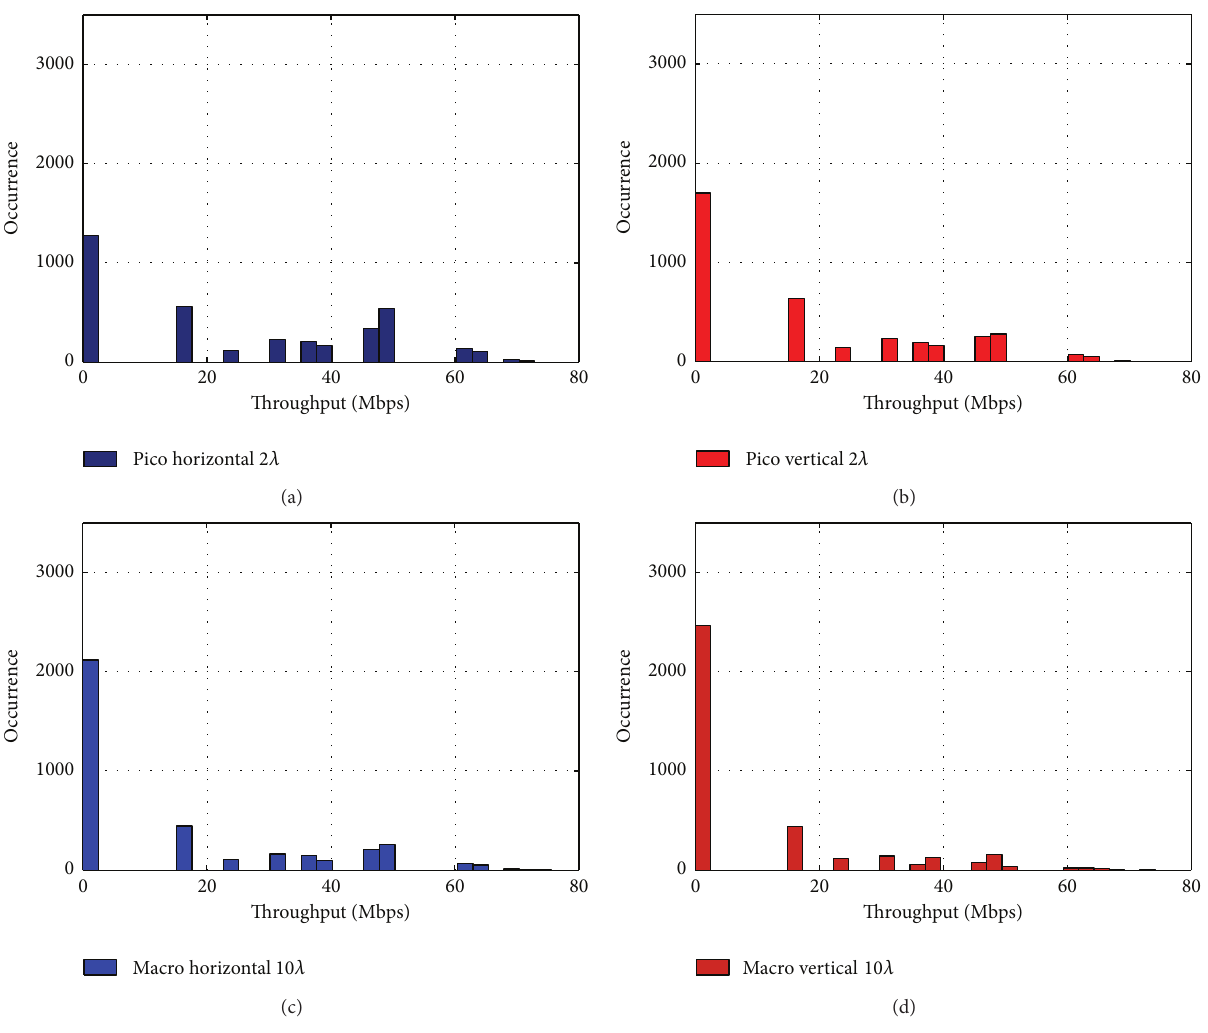
Figure 10: Throughput occurrence statistics for vertical and horizontal eNB antenna array configurations (NLoS links only) with various BS antenna separations (total number of occurrences is 3,729 for picocells and 3,681 for